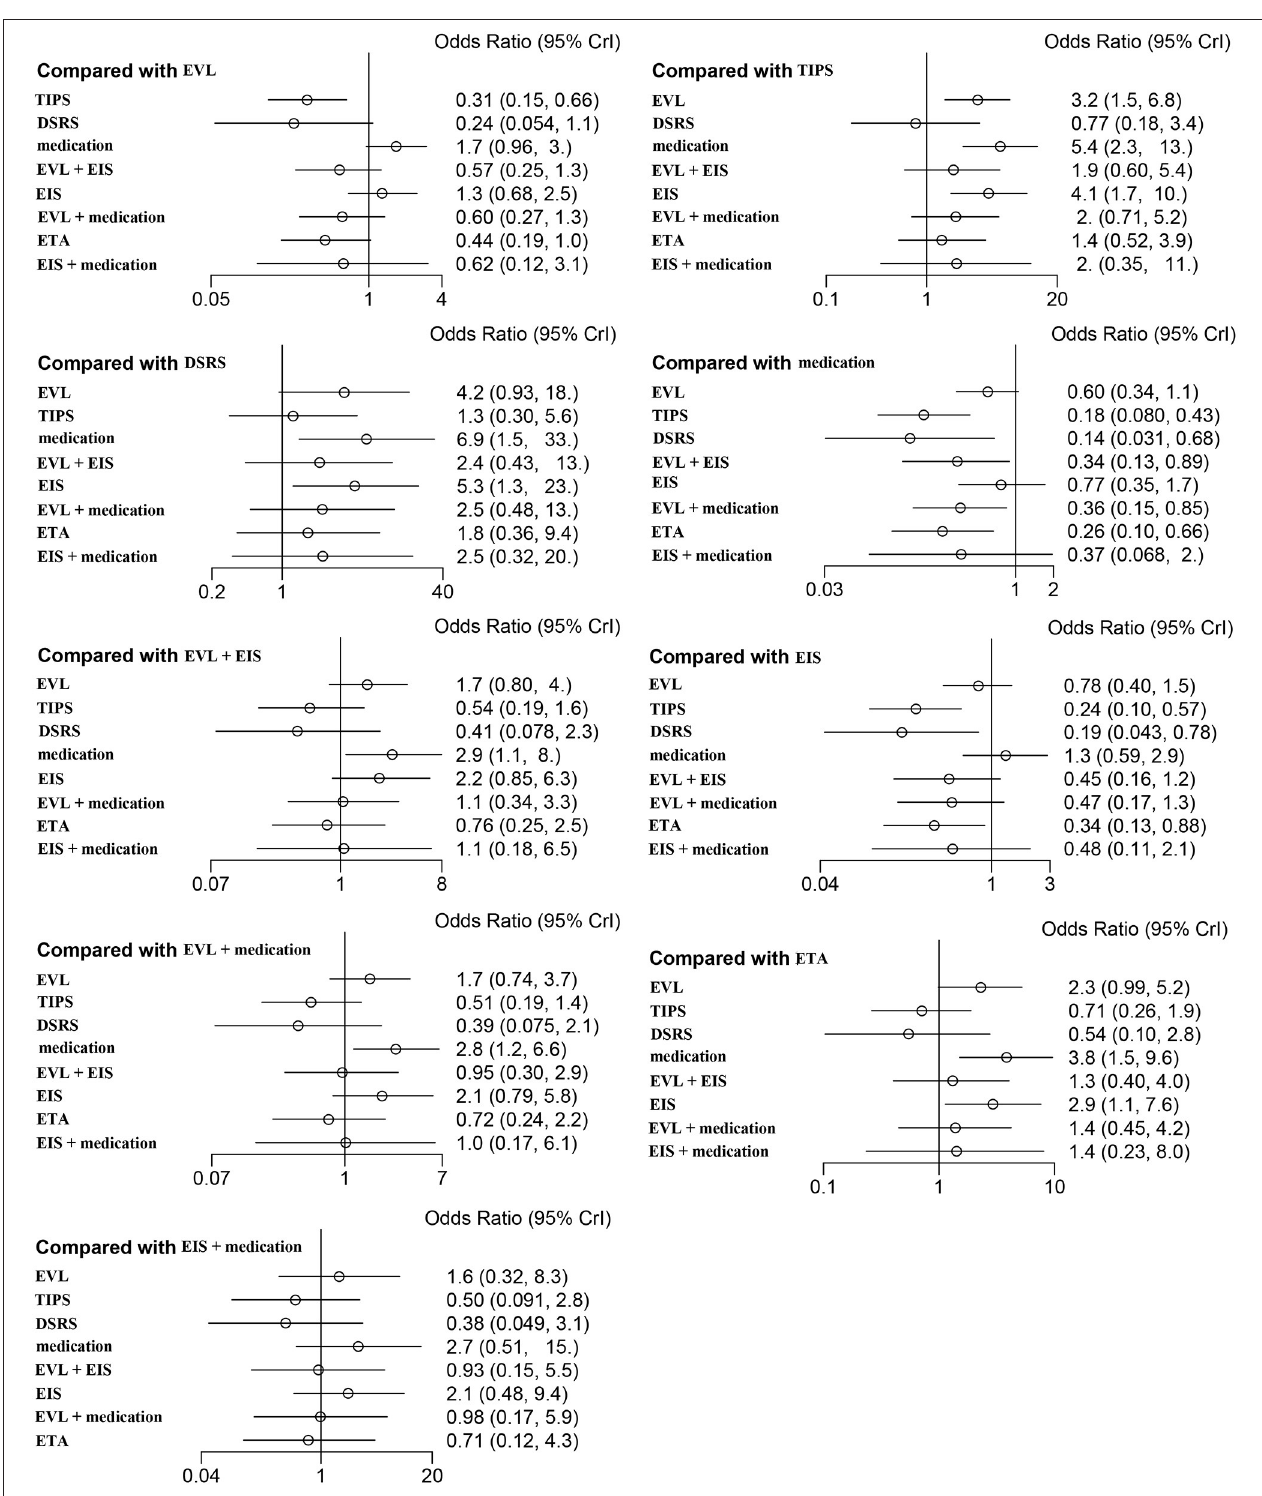
FIGURE 3 | Forest plot of the odds ratios for all-cause rebleeding based on different pairwise comparisons. EVL, endoscopic variceal ligation; TIPS, transjugular intrahepatic portosystemic shunt; DSRS, distal splenorenal shunt; EIS, endoscopic injection sclerotherapy; ETA, endoscopic tissue.